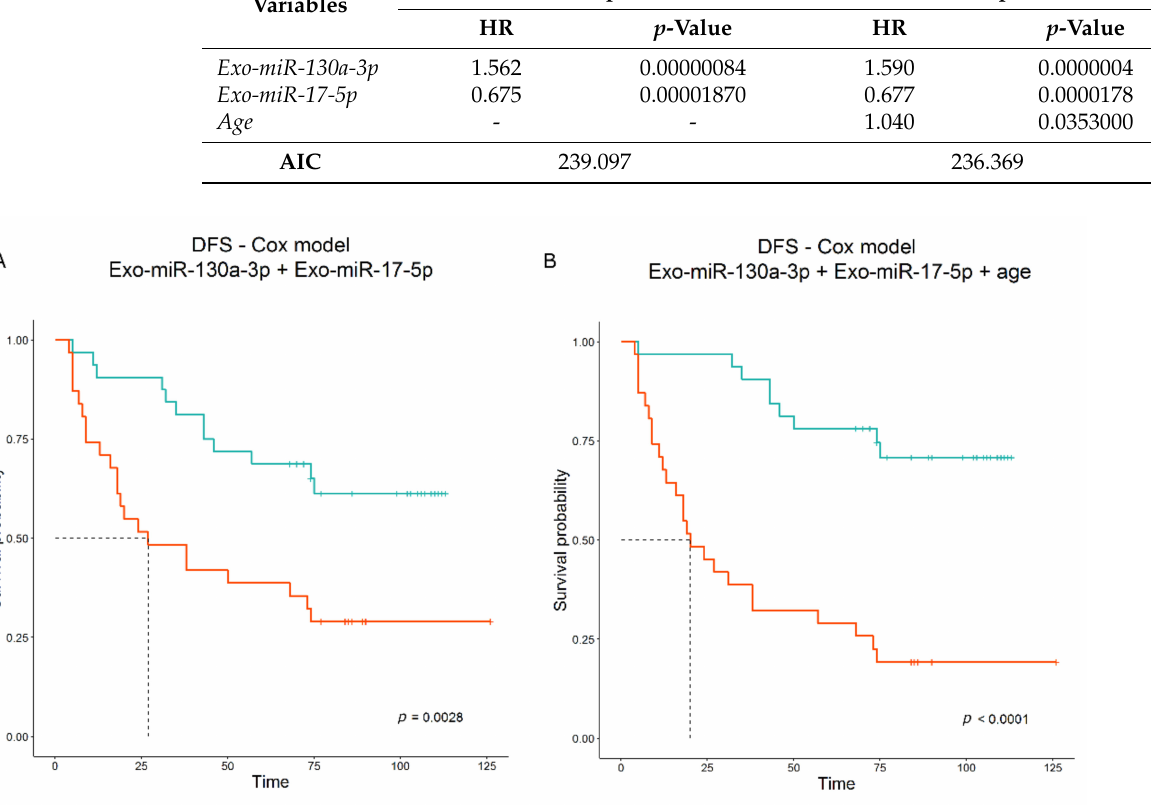
Figure 3. ( A ) Kaplan–Meier curves obtained by stratifying 63 patients according to the model score that combines Exo-miR-130a-3p and Exo-miR-17-5p (ddPCR data). Median DFS is 27 months. ( B ) Kaplan–Meier curves obtained by stratifying 63 patients according to the model score that combines Exo-miR-130a-3p, Exo-miR-17-5p (ddPCR data) and age. Median DFS is 20